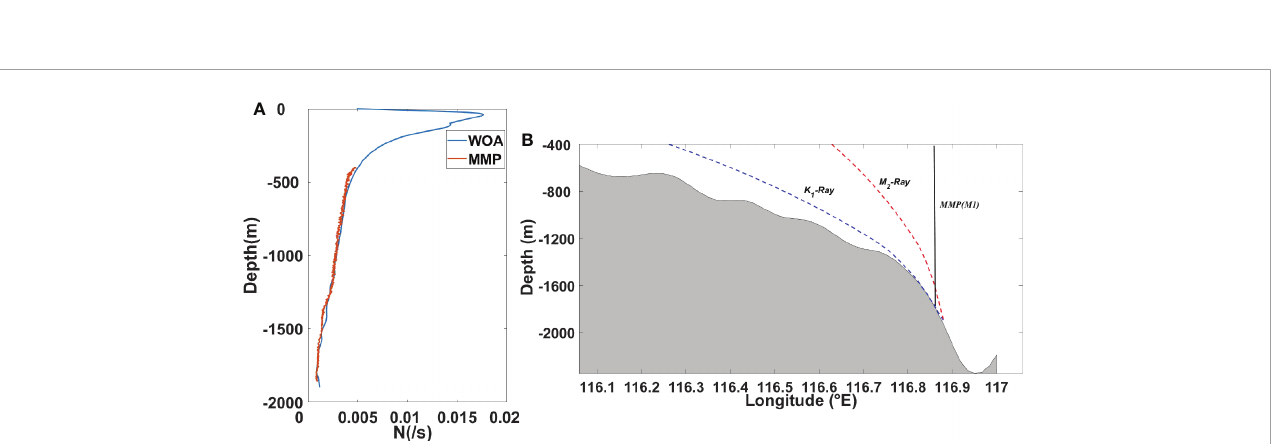
FIGURE 2 (A) Pro fi les of N w (blue) and N m (red) are computed from climatological data near M1 and from the mooring data, respectively. (B) A cross-slope section crossing M1. The blue and red dotted line are the ray paths of K 1 and M 2 , respectively. The black thick line is the mooring